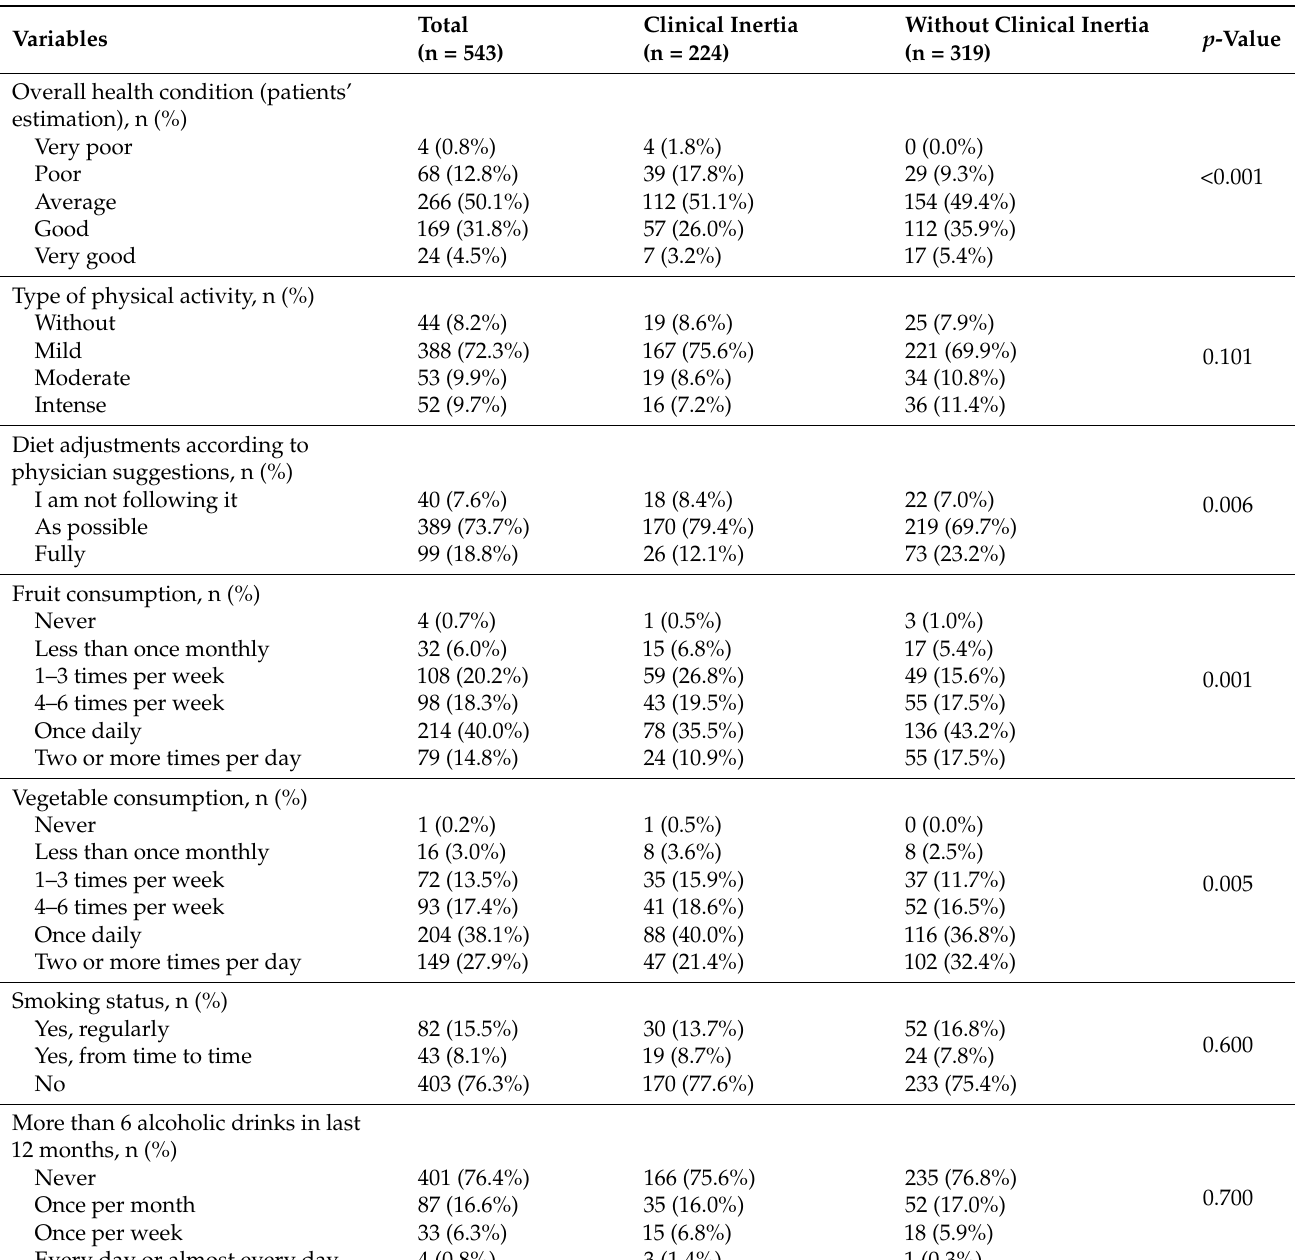
Table 2. Overall health condition and patients’ behavior in relation to clinical inertia in the treatments of type 2